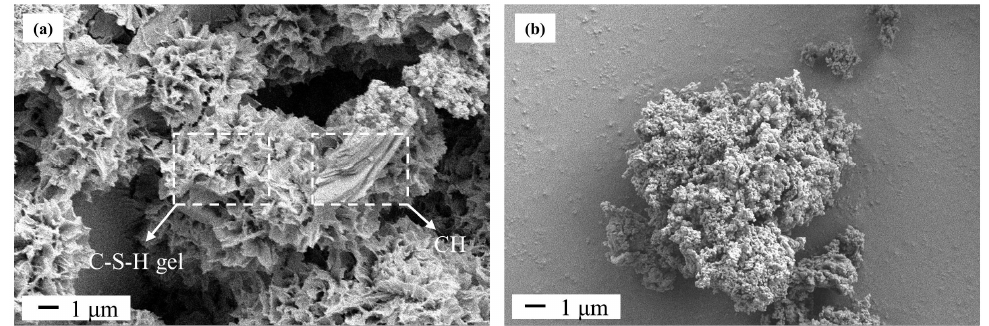
Figure 5. SEM images of hydrated cement M0 ( a ) and after calcination M900 ( b ).